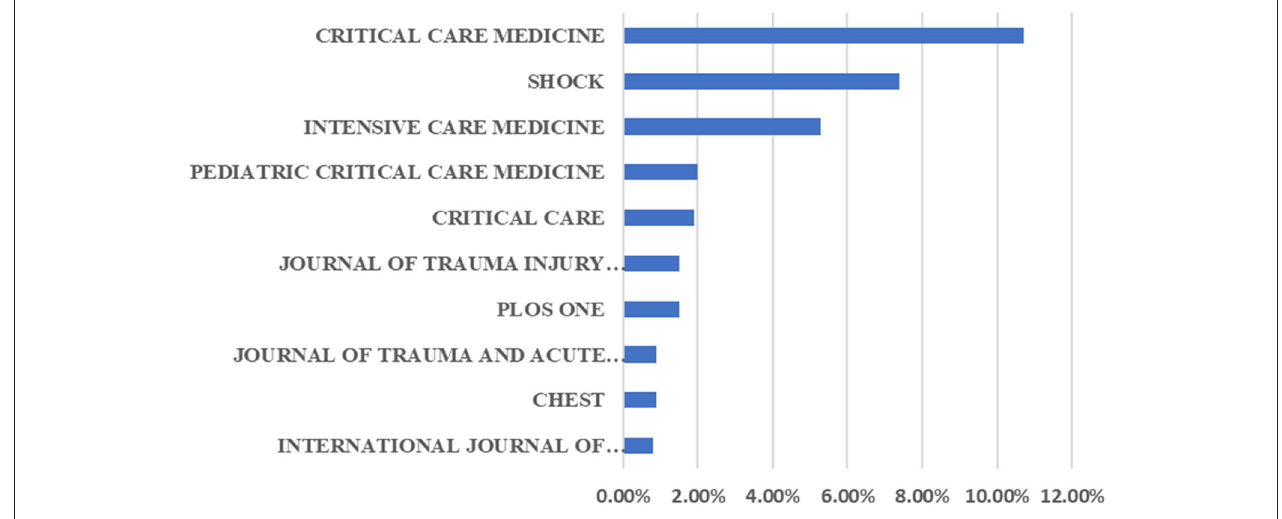
FIGURE 7 | The top 10 journals publishing research on